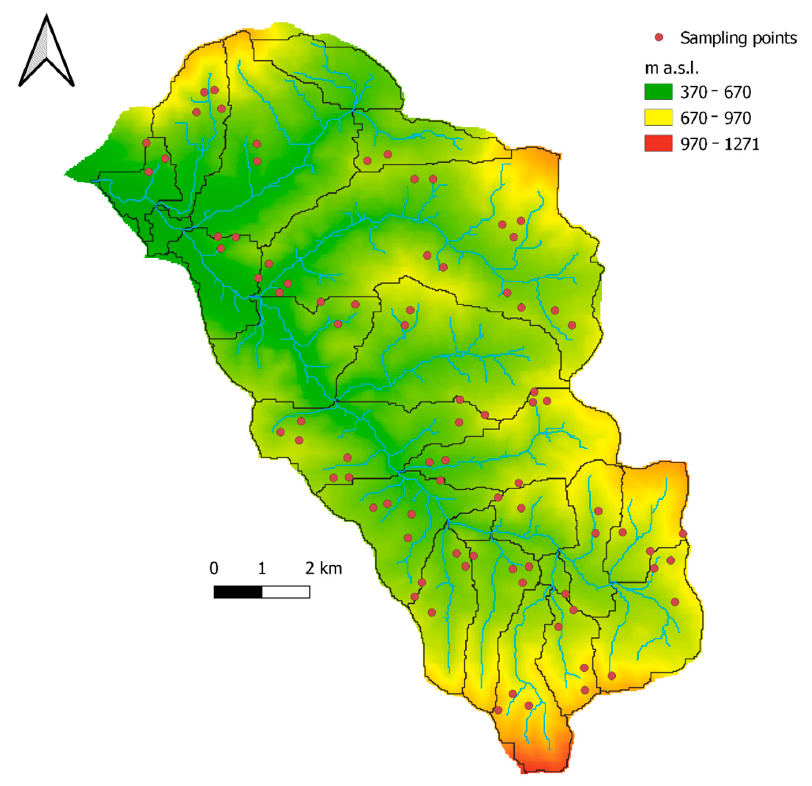
Figure 2. Location of sampling in Mszanka catchment.